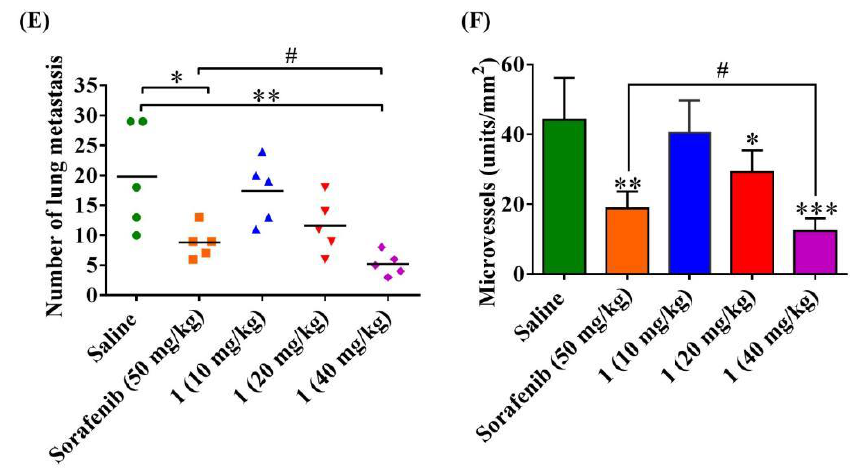
Figure 9. Compound 1 suppressed the tumor metastasis and angiogenesis in 4T1 mammary carcinoma model. Representative bioluminescent images showing primary (mammary fat pad) and metastatic (lung) breast tumors at different time points (0, 7, 14, 21, 28 and 29 days), and excised lungs at the end of the experiment ( A ). Bouin’s solution-filled images of lung ( B ) and the number of lung metastatic nodules in different treatment groups ( C ). IHC staining of CD31 in tumor tissues ( D ) with the microvessel density (MVD) ( E ). H&E staining of lung tissues in each group ( F ). ( n = 5, means ± SEM are shown, * p < 0.05, ** p < 0.01, *** p < 0.001, compared with Saline treatment group; # p < 0.05, compared with Sorafenib treatment group.) Scale bar = 200 μm.